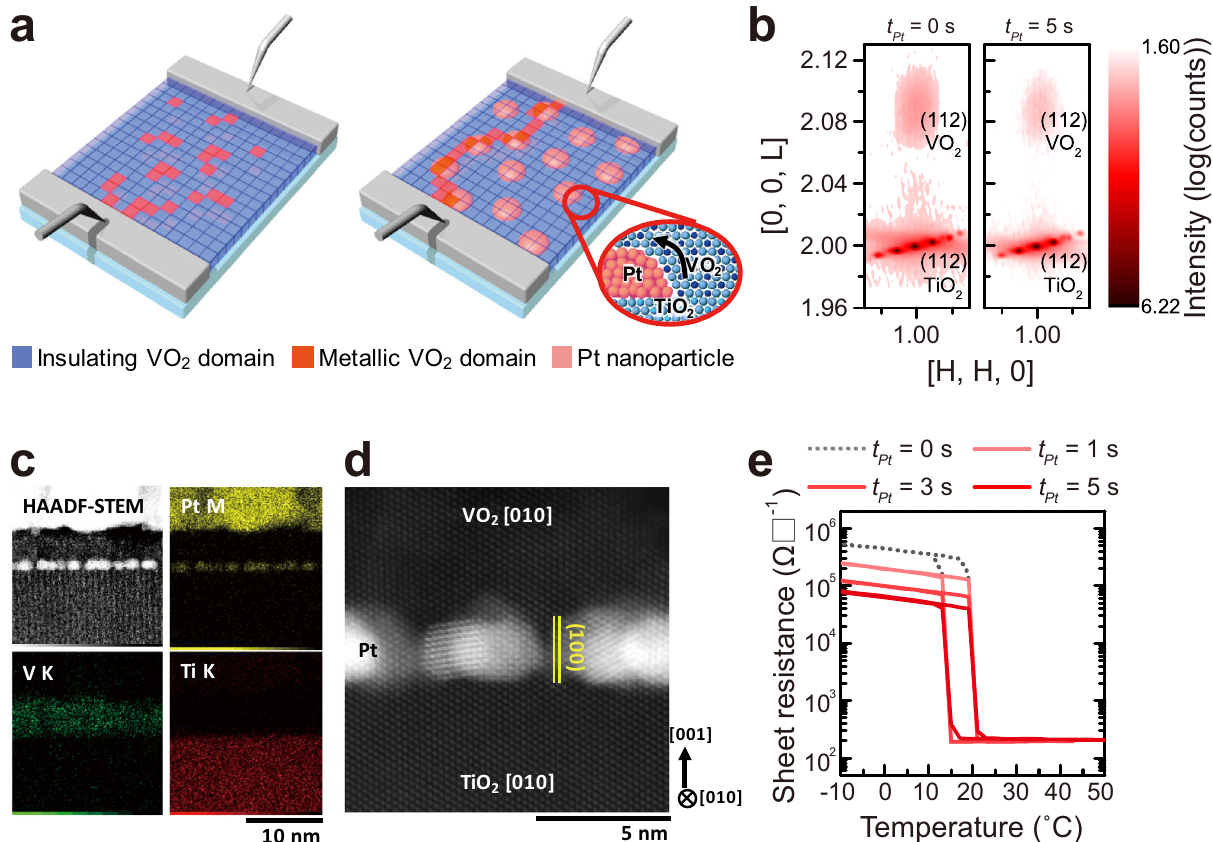
Fig. 1 | Single-crystal-like VO 2 fi lms embedded with Pt nanoparticle (NP). a Schematics of epitaxial VO 2 fi lms on (001)-TiO 2 substrates and Pt NP-decorated (001)-TiO 2 substrates. VO 2 epitaxial fi lms are selectively nucleated on TiO 2 single- crystalsubstratesand epitaxiallyand laterallyovergrown onto Pt NPs, which act as “ stepping stones ” for electrical conduction by insulator-to-metal transition. b Reciprocal space mapping around the (112) re fl ection of (001) TiO 2 substrate. Coherently tensile-strained VO STEM image and elemental EDS mapping of VO 2 epitaxial fi lms on Pt NP-TiO 2